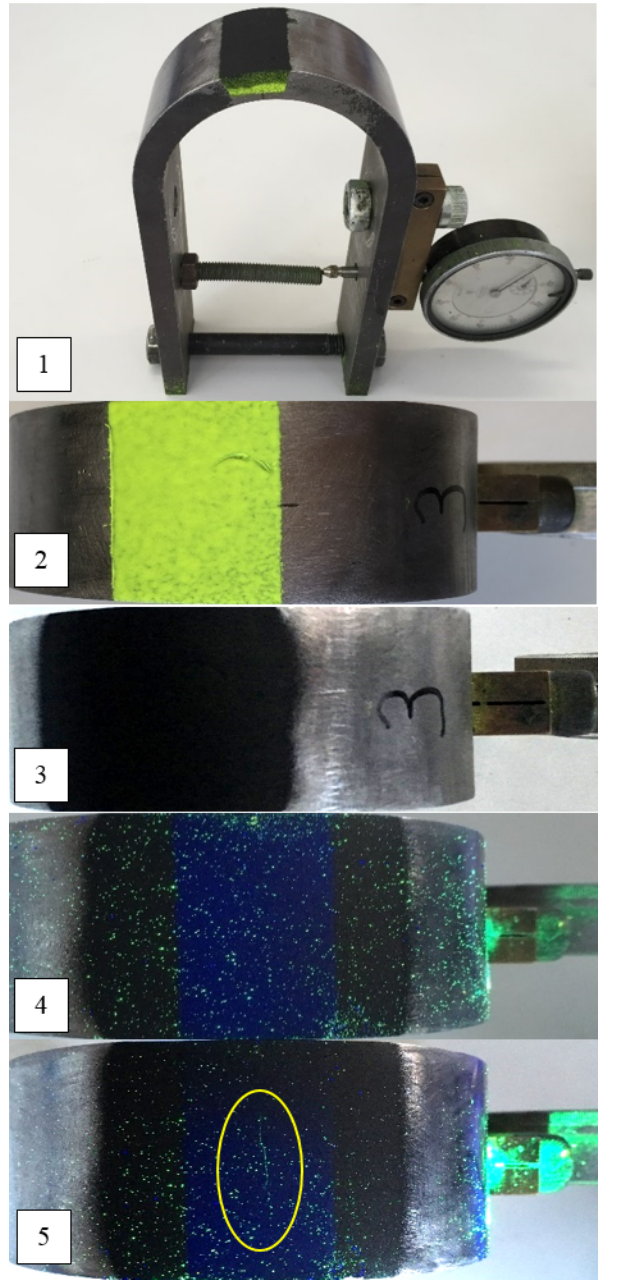
Figure 2. Pictures numbered from top: (1) special test body with dial gauge, (2) applied with fluorescent layer, (3) covering layer, (4) under UV rays, and (5) the detected developing crack at a spe- cific strain (Makris et al.